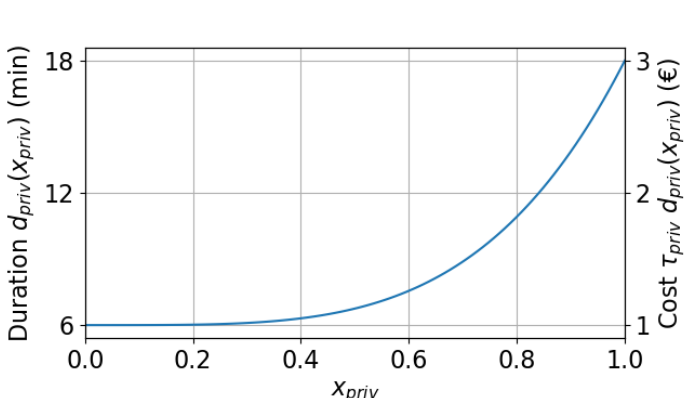
Figure 2. Travel duration d priv ( . ) (and the associated cost τ priv d priv ( . ) , along the right axis) for vehicles driving downtown depending on their proportion x priv . If all vehicles choose the private transport mode, the associated duration will be three times higher than the free-flow case (when all vehicles choose public